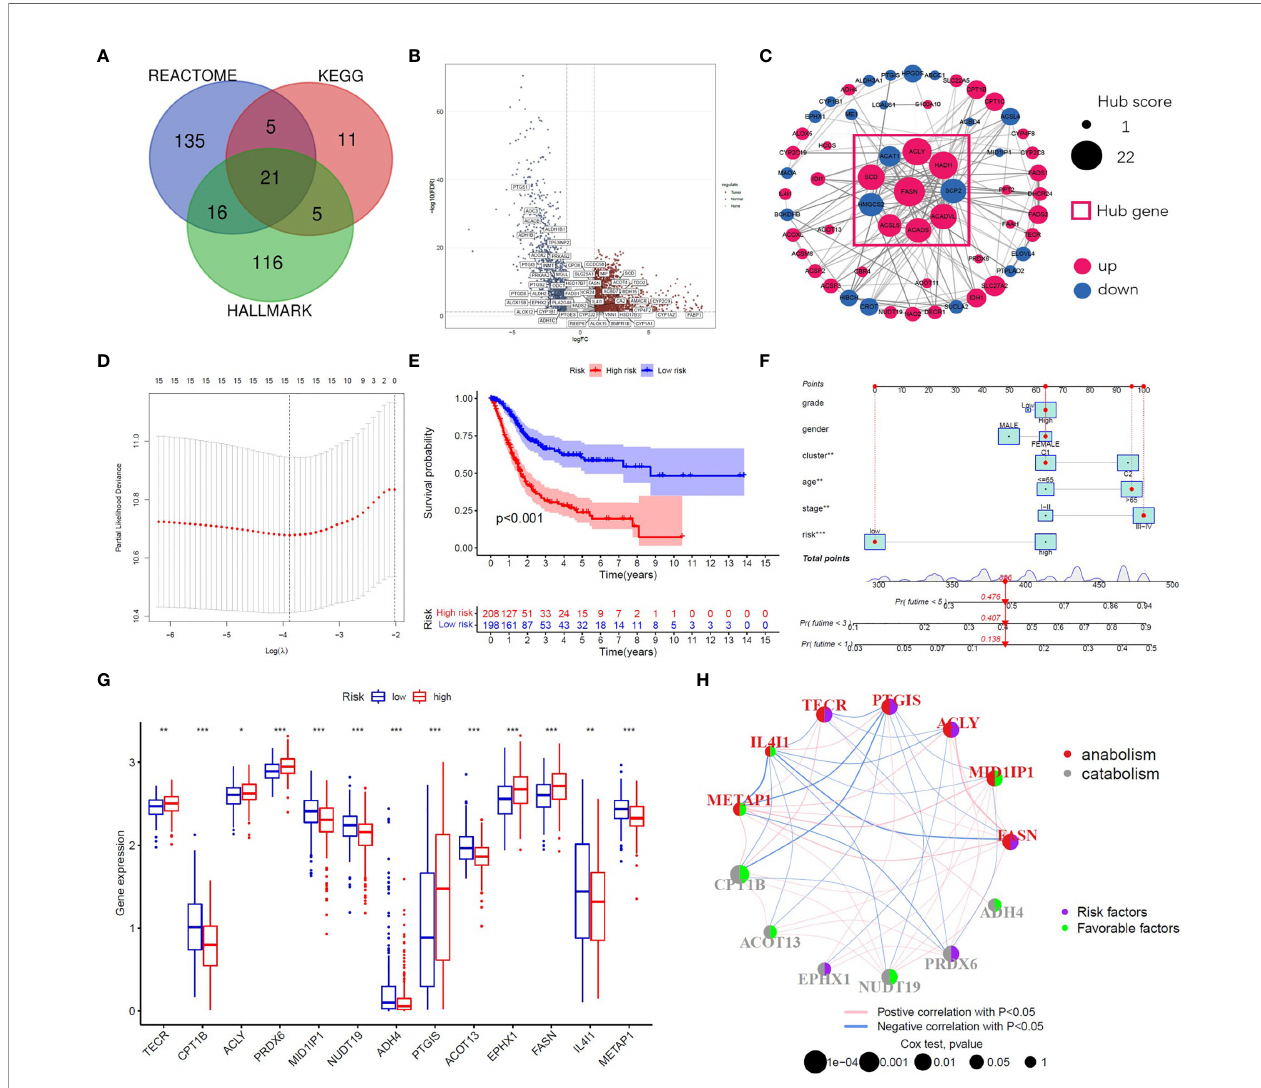
FIGURE 1 | Identi fi cation of prognostic FAM genes and risk score model. (A) Venn diagram of 309 FAM genes from KEGG, HALLMARK and REACTOME. (B) Volcano plot of 52 fatty acid metabolism-related DEGs (p<0.05). (C) PPI network and hub genes of 68 prognostic FAM genes. (D) Cross-validation for tuning the parameter selection in the LASSO regression. (E) Kaplan – Meier survival curve of the patients between the high- and low-risk groups. (F) Nomogram containing risk, cluster and clinicopathological features. (G) Differential expression of the 13 model genes between different risk groups. (H) Risk and functional groups of the 13 model genes. (*p < 0.05, **p < 0.01, ***p <